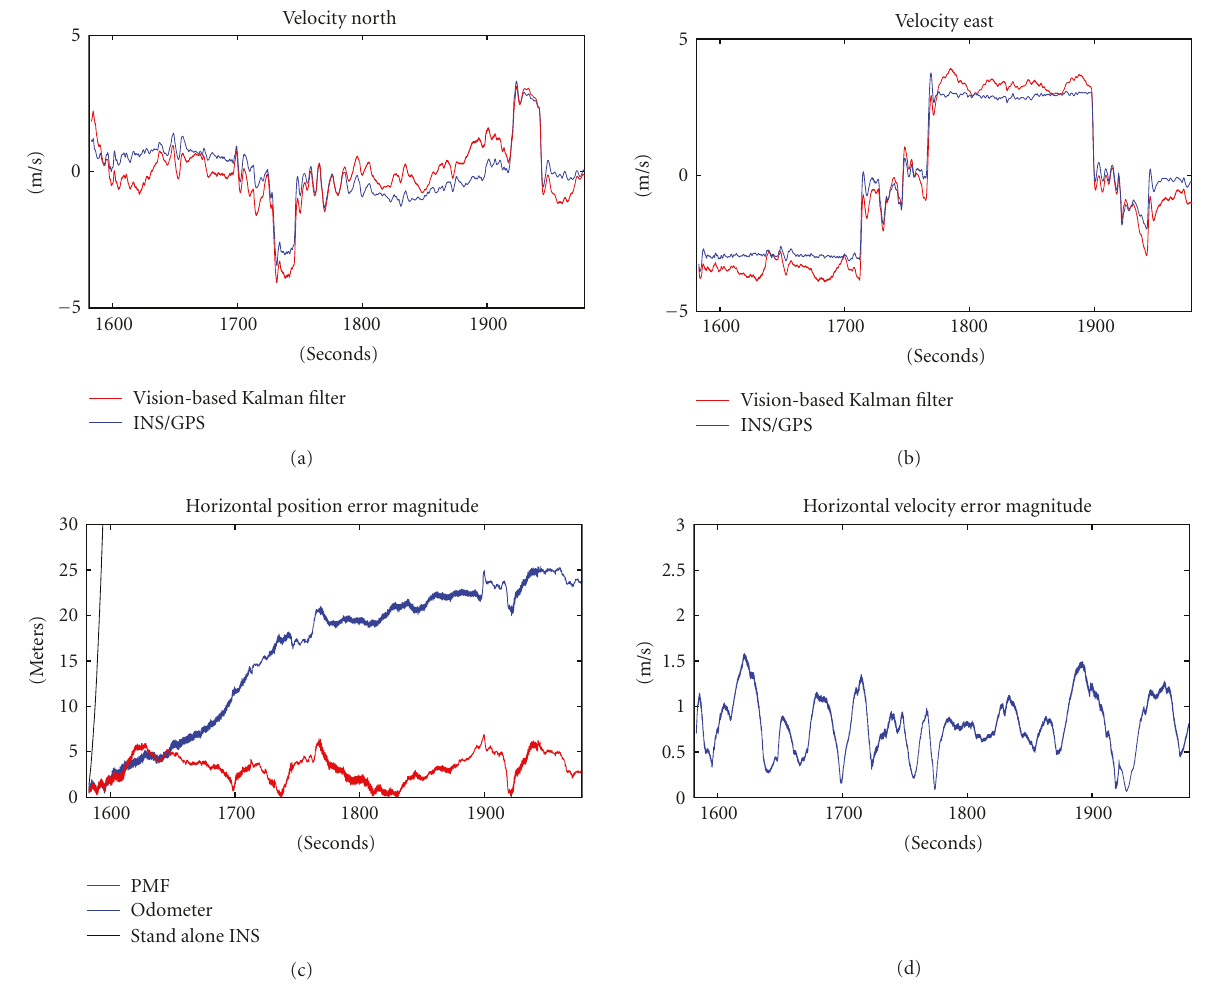
Figure 10: (a) and (b) depict the north and east velocity components estimated by the Kalman filter while (d) depicts the horizontal velocity error magnitude. In (c) the position error comparison between PMF, odometry, and stand alone INS is